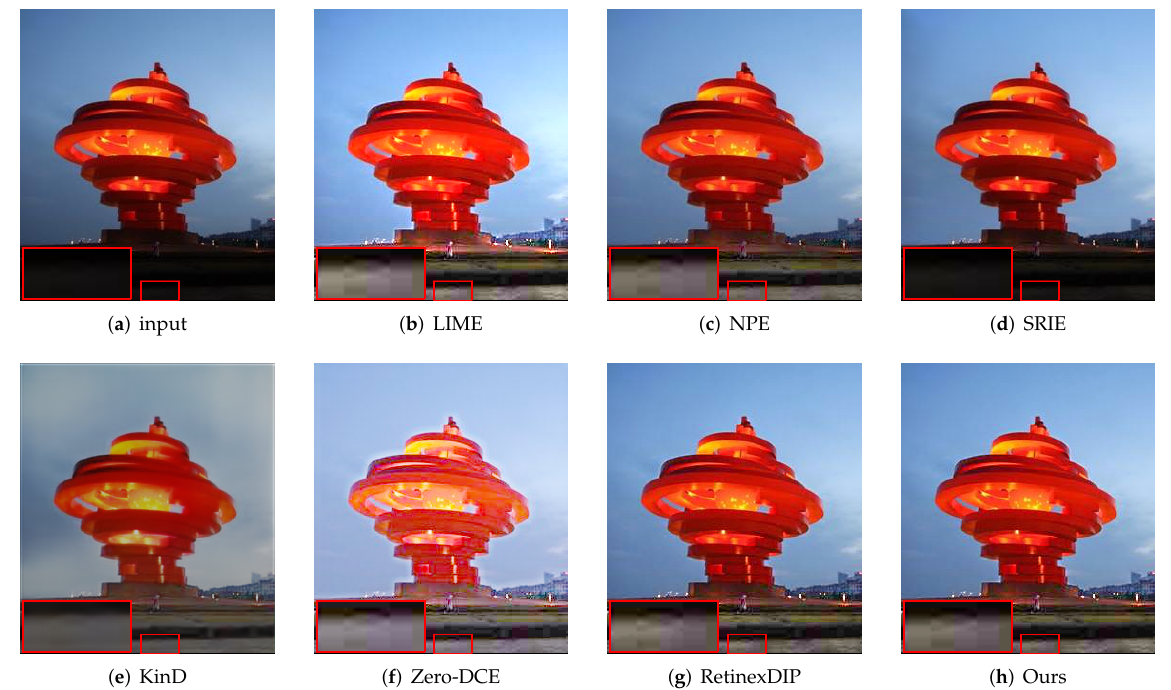
Figure 4. Comparisons of enhanced images. Red boxes indicate the obvious differences. Compared with other methods, our method enhances the image and the edges are clearly